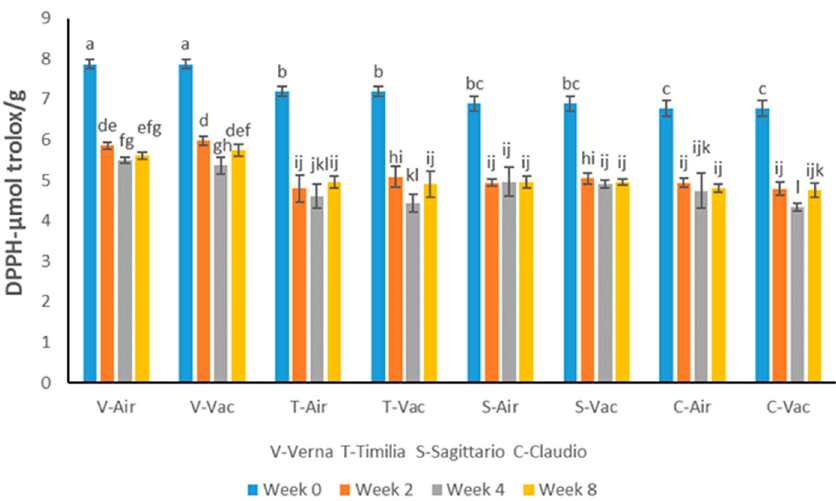
Figure 1. Antioxidant activity shown by DPPH assay of four wheat cultivars storage in different conditions and for different lengths of time. Different letters show significant differences at p < 0.05.